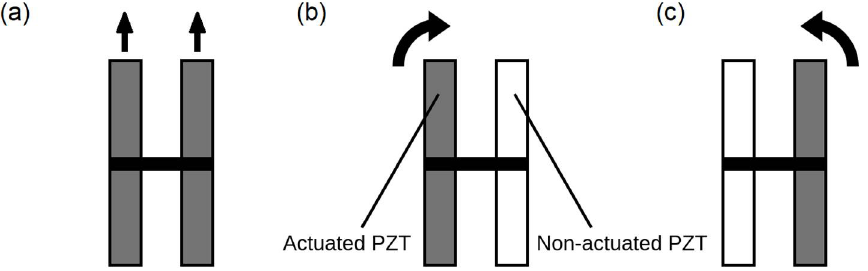
Figure 5. Top view of the H-shaped locomotion system with identification of the three possible ways of motion: ( a ) forward motion with both plates actuated, ( b ) clockwise rotation with left plate actuated, ( c ) counterclockwise rotation with right plate actuated.